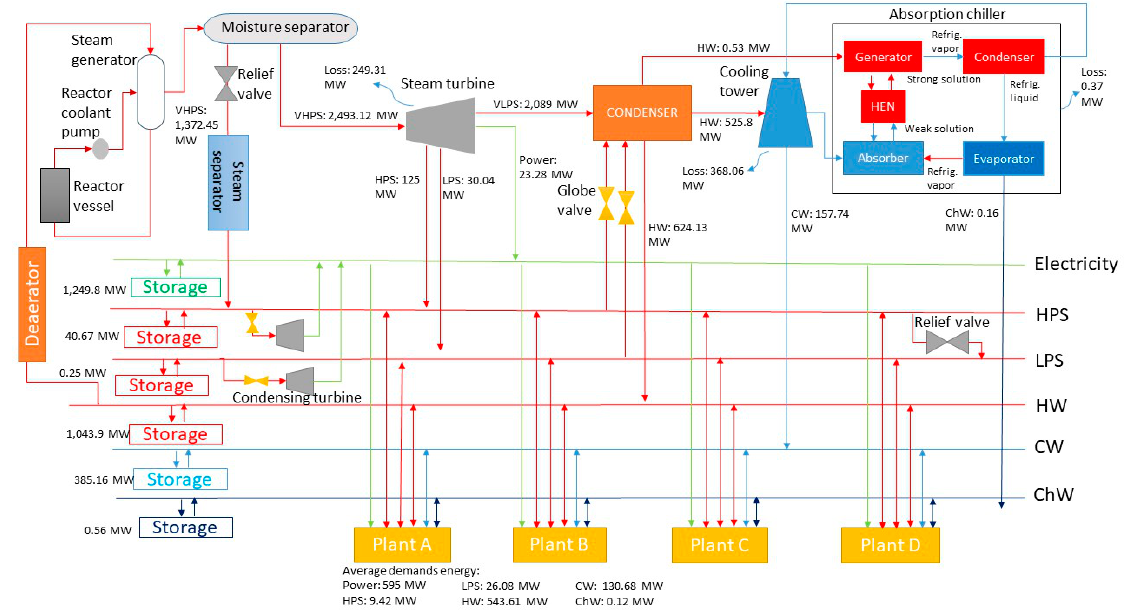
Figure 7. The final optimal energy network for the centralized trigeneration system to be supplied to the Total Site system.